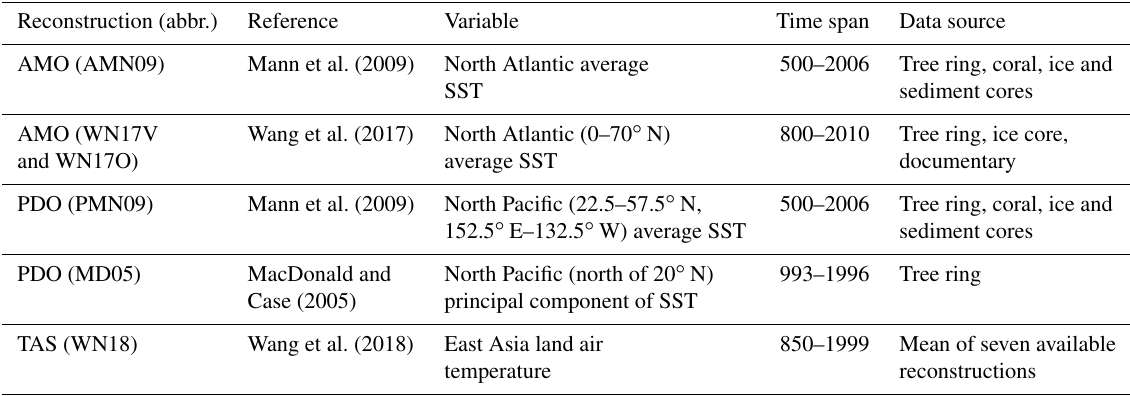
Table 2. Summary of the paleoclimate reconstructions considered in this study. Reconstruction